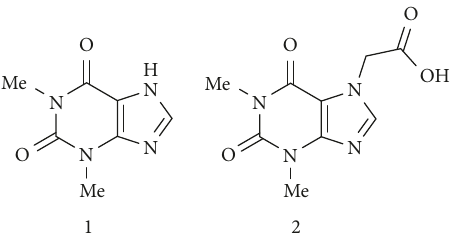
Figure 1: Structures of theophylline ( 1 ) and acefylline ( 2